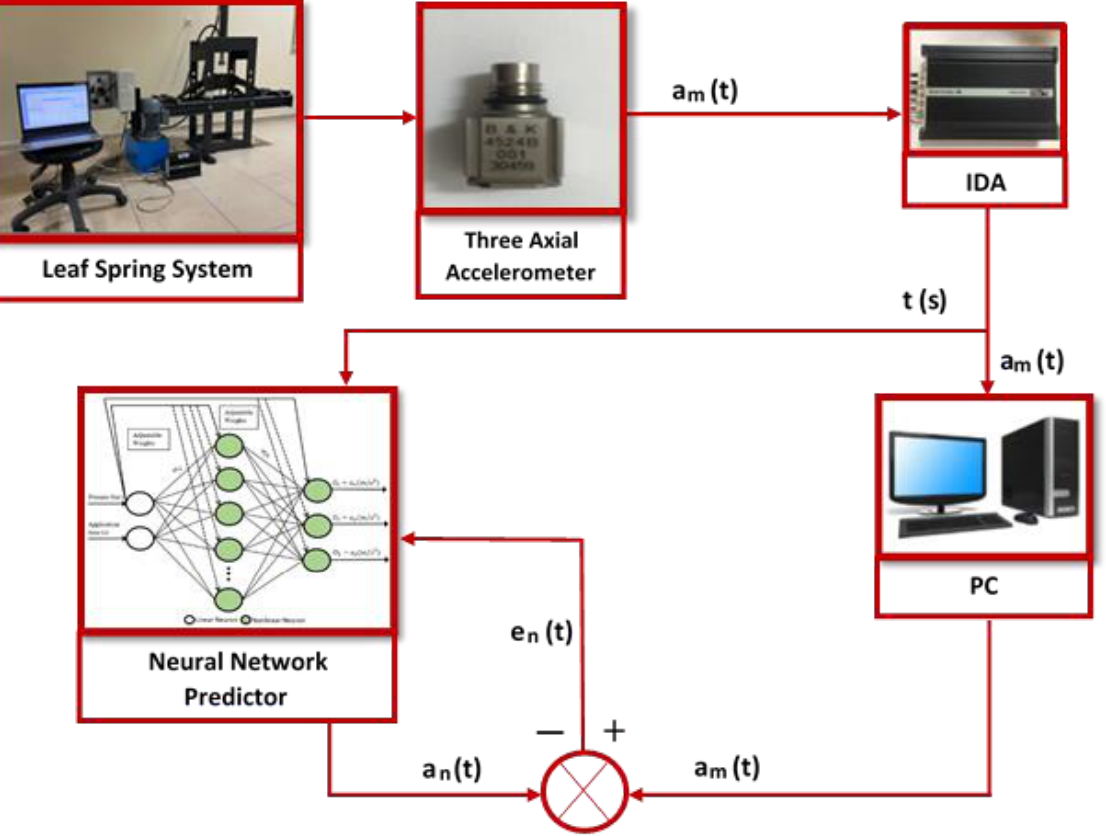
Figure 7. The block diagram of the whole system and consisting of both experimental and simulation approaches.